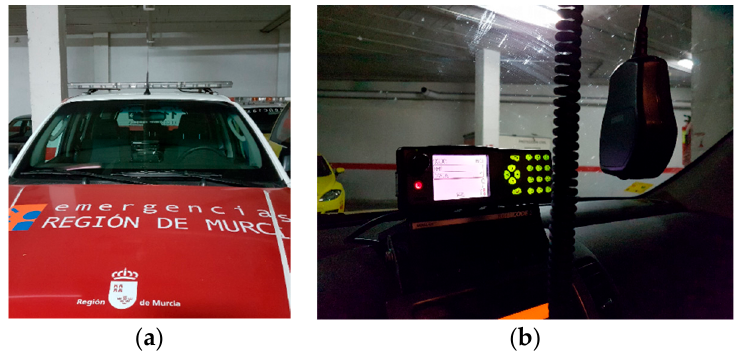
Figure 2. ( a ) Four-wheel drive vehicle with the TETRA antenna and ( b ) TETRA Mobile station equipment.